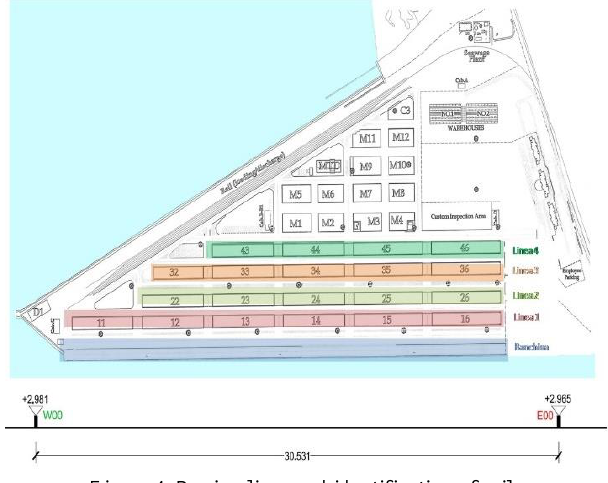
Figure 4. Racing lines and identification of